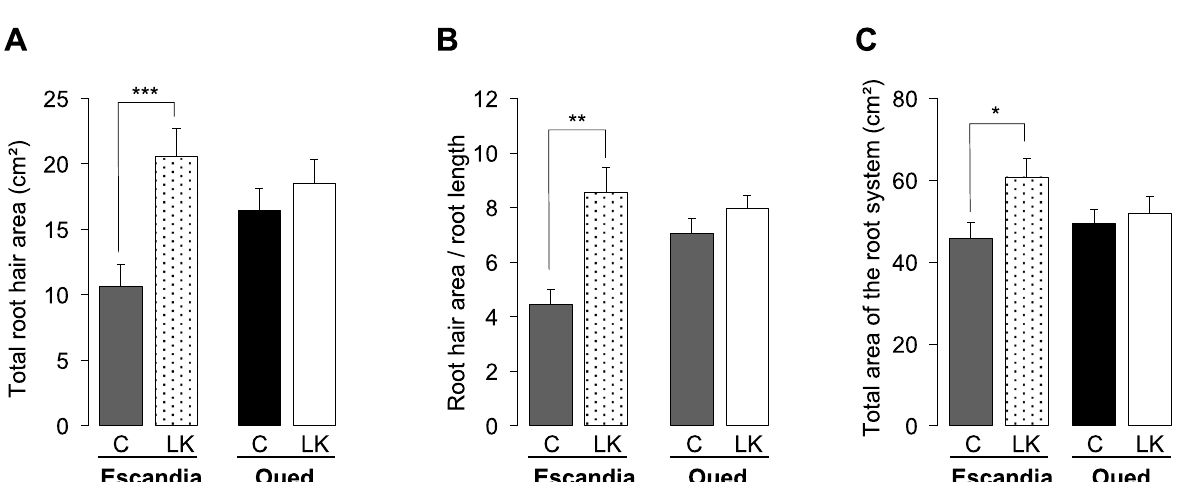
Fig. 7 Effect of K + shortage on root system and root hair surface areas in Escandia and Oued Zenati wheat seedlings. Plants were grown for 14 days in rhizoboxes in control or K + shortage conditions (see legend to Fig. 2). Plants were the same as in Figs. 5 and 6. A Total root hair surface area. B Ratio of total root hair surface area (cm 2 ) to total root (seminal lateral) length (cm), as an average root hair surface over the root system. Total root + (seminal lateral) length data were from Fig. 5A). C Entire root system surface area (roots root hairs). Areas were measured using WinRHIZO ™ , + + the diameter classification parameters being set so that root hairs were assimilated to root elements with a diameter smaller than 0.2 mm. Root elements displaying a diameter equal to or larger than 0.2 mm were classified as roots. Means SE ( n 10 for control condition, and 14 for low K + ± = condition, in Escandia; n 14 for both conditions in Oued Zenati). *, ** and *** denote statistically significant differences (Student t test; p < 0.05, = 0.01 or 0.005, respectively) between the values in control condition and the corresponding values in K + shortage